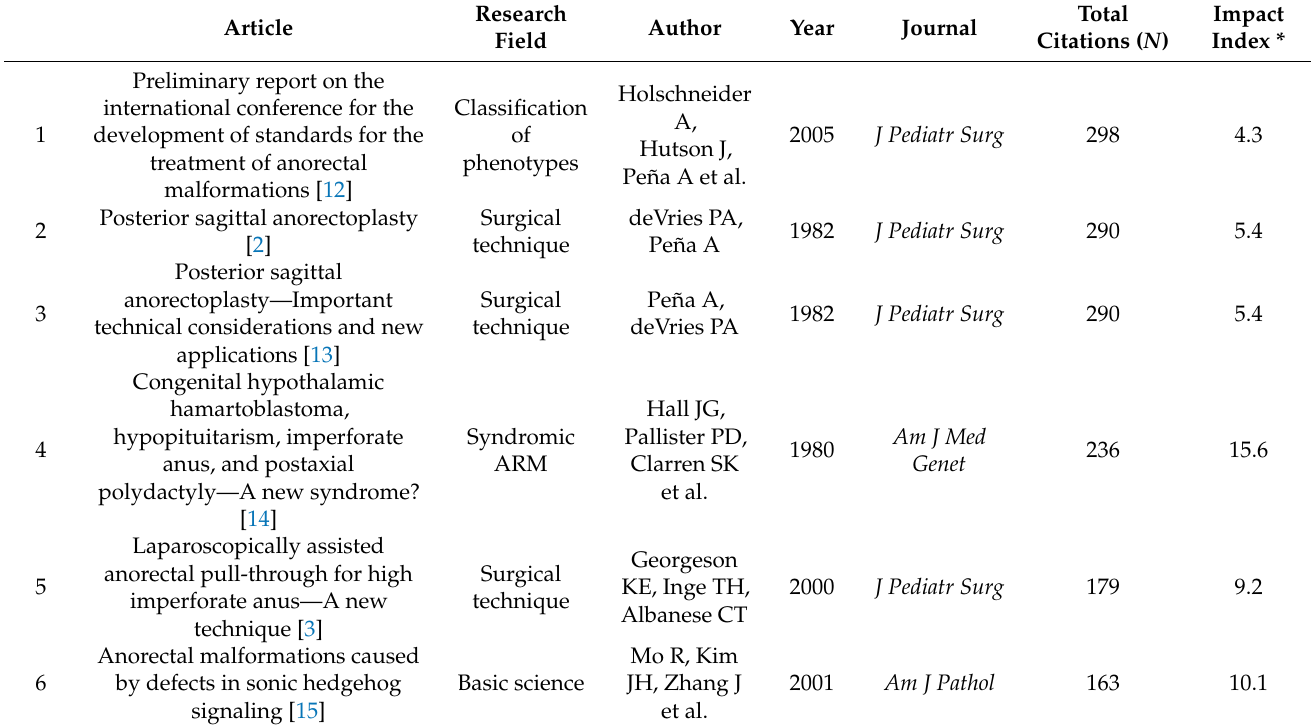
Table 4. Most cited original research publications on ARM between 1970 and